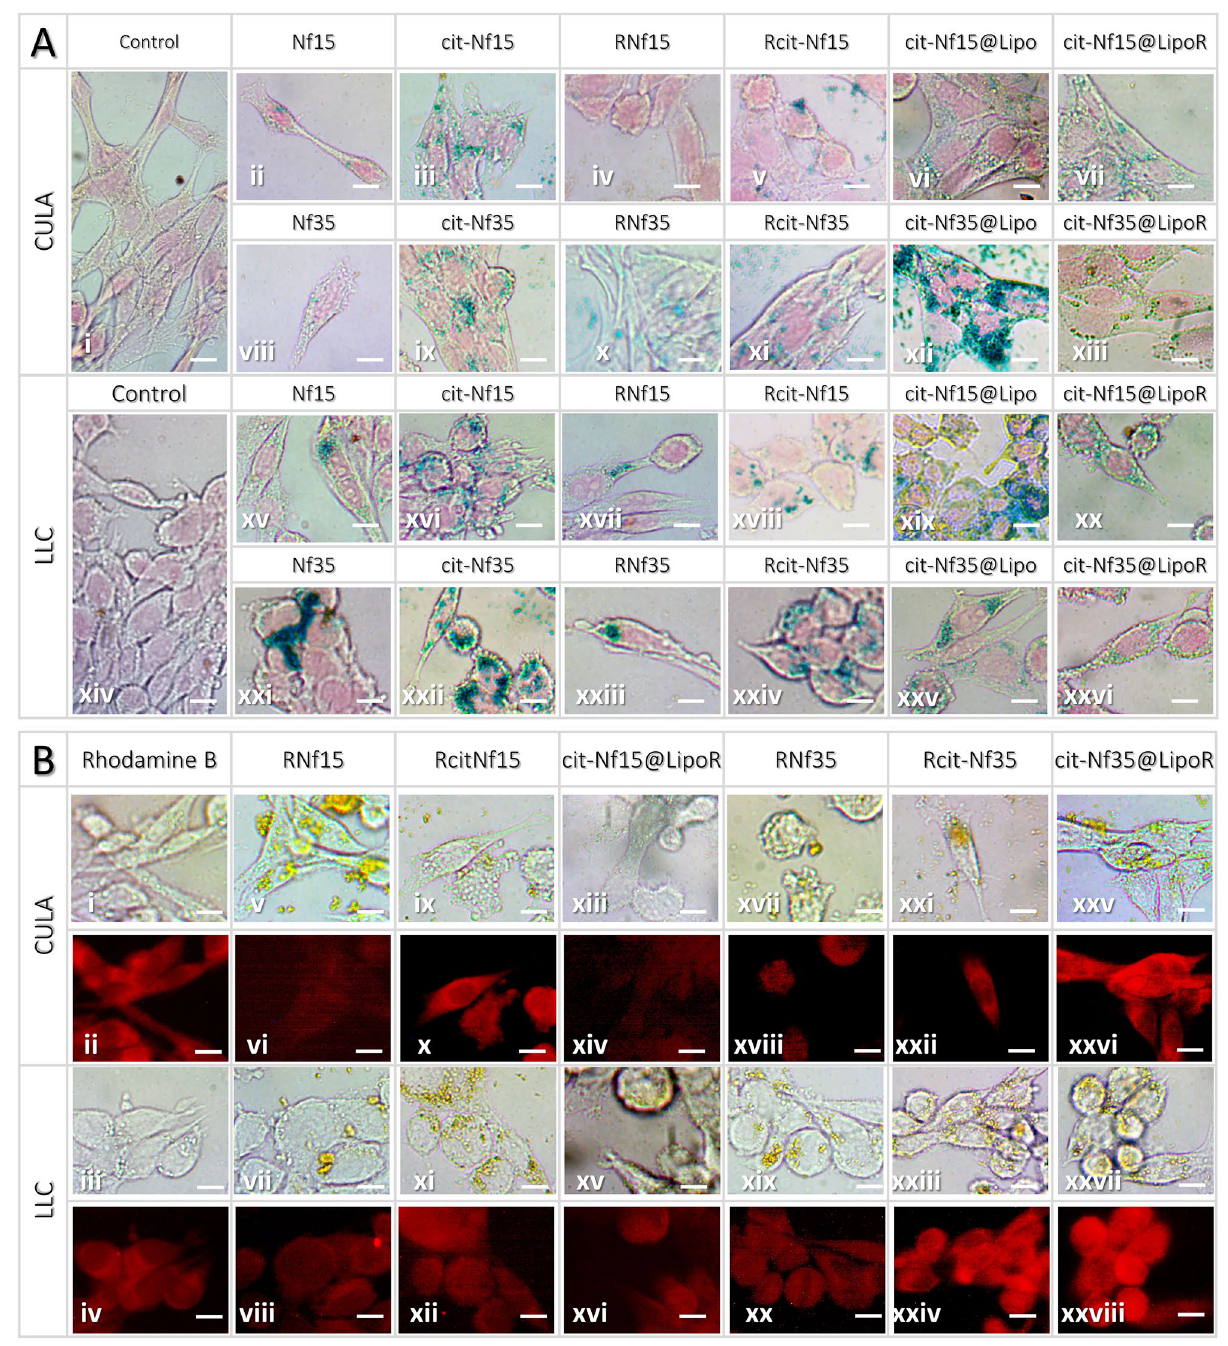
Figure 6. ( A ) Optical microscopy images of all Nf formulations stained with Prussian blue ( B ) Fluorescent microscopy images of RhB modified samples. Both sets of images were acquired after 24 h treatment and incubation in either CULA or LLC cell lines. (All scale bars at 10